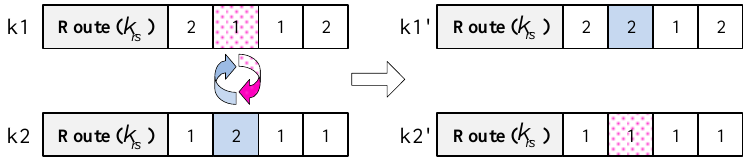
Figure 5. Illustration of crossover for sub-chromosome k.